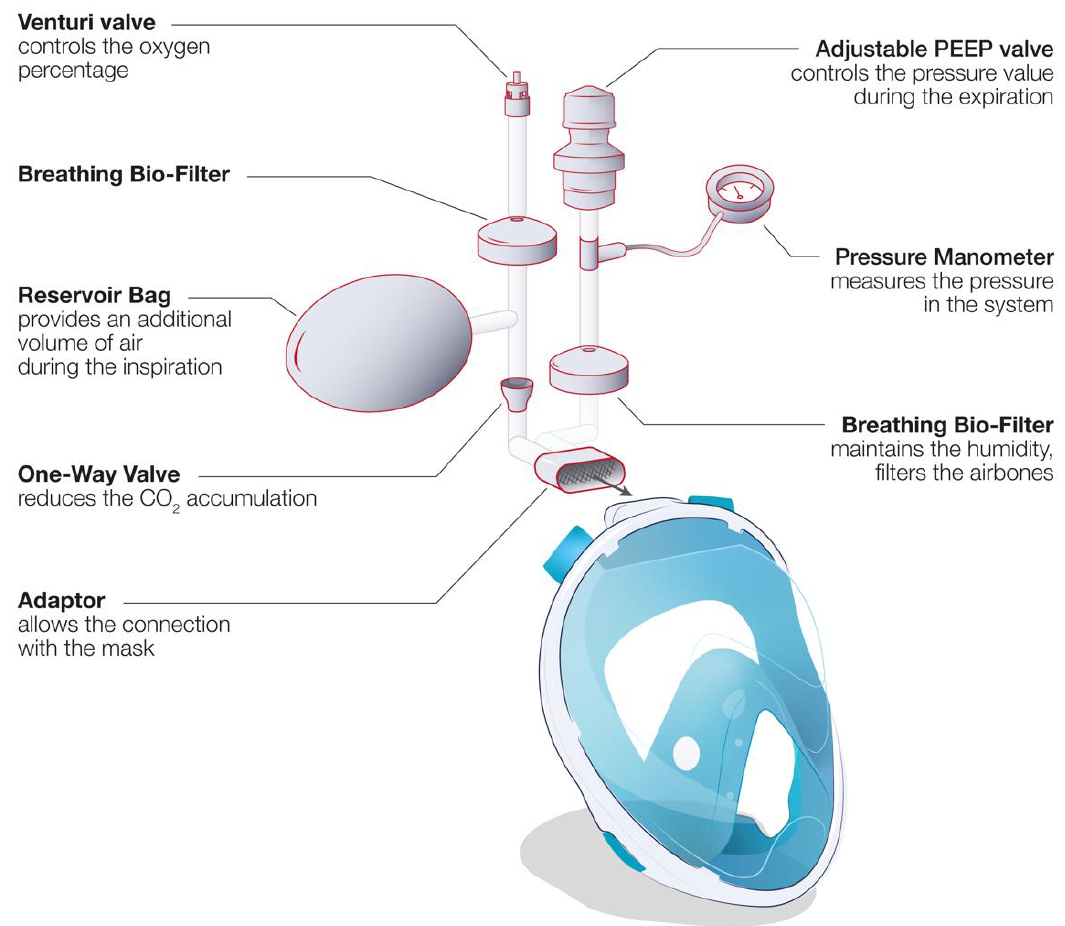
Figure 4. Full-face snorkeling mask adapted for use as a non-invasive ventilation device: schematic of the different components when using a Venturi valve and function of each element.